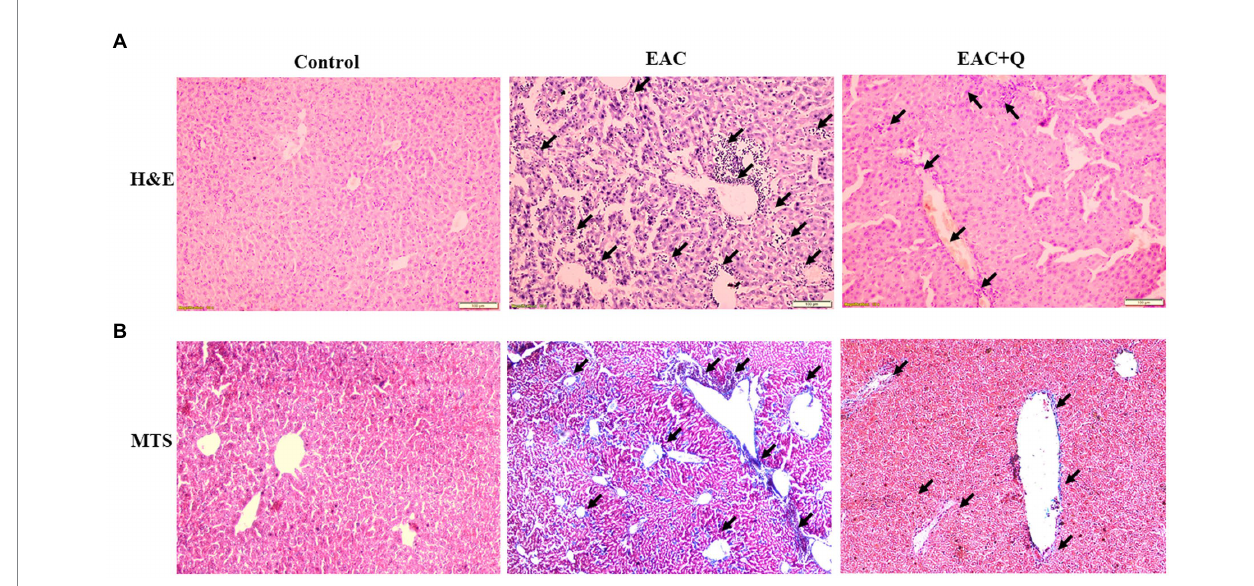
FIGURE 4 Quercetin ameliorates EAC induced hepatic inflammation and fibrosis. (A) Hematoxylin and Eosin staining of quercetin treated EAC animals when compare to EAC bearing animals demonstrating decreased inflammatory cells infiltration ( n = 5/group). (B) Liver section of quercetin treated EAC animals when compared with control EAC bearing animals staining with Trichome Masson’s staining showing decreased liver fibrosis ( n = 5/group). The arrow mark indicates inflammatory cells infiltration in H&E staining and degree of fibrosis in TMS